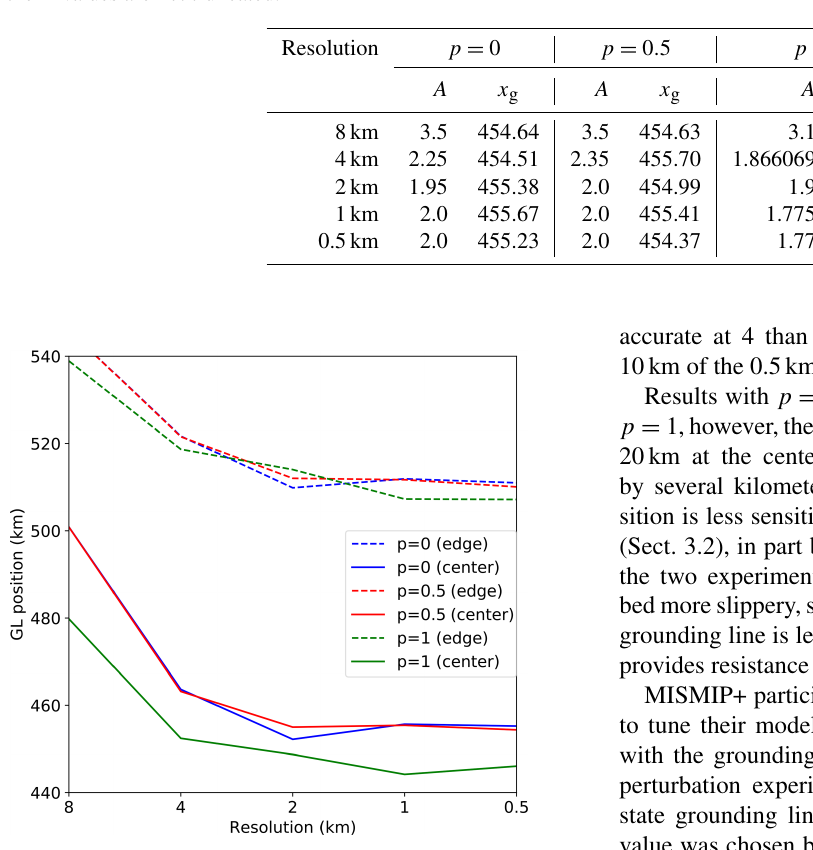
Table 3. Without this tuning, given the nonlinear bed